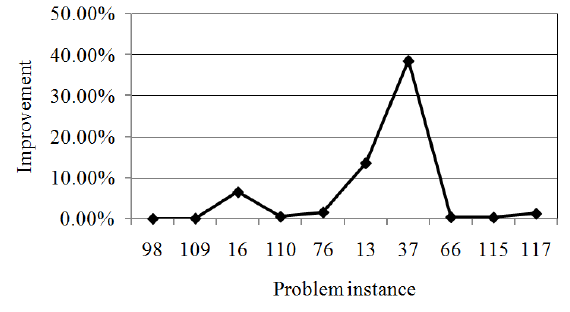
Fig. 2. Improvement of ACO GO over ACO -GO .